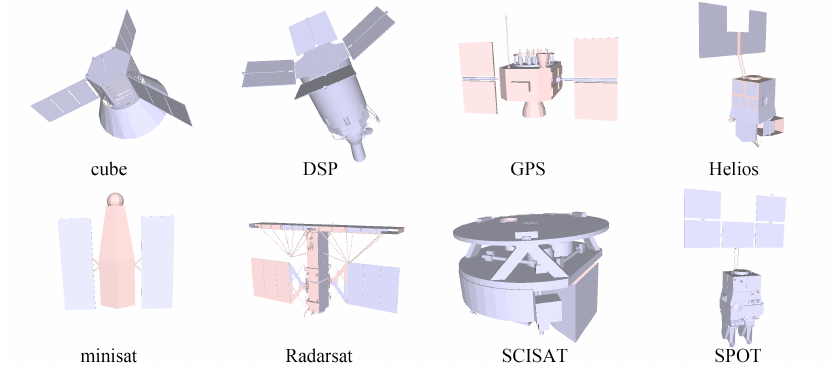
Figure 5. Origin CAD mesh models of 8 spacecraft. Synthesized point clouds are generated by sampling surfaces of these